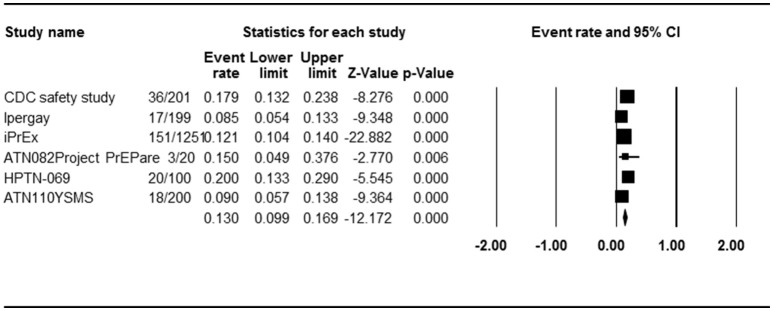
Forest plot for overall analysis of PrEP and any AEs (ER).